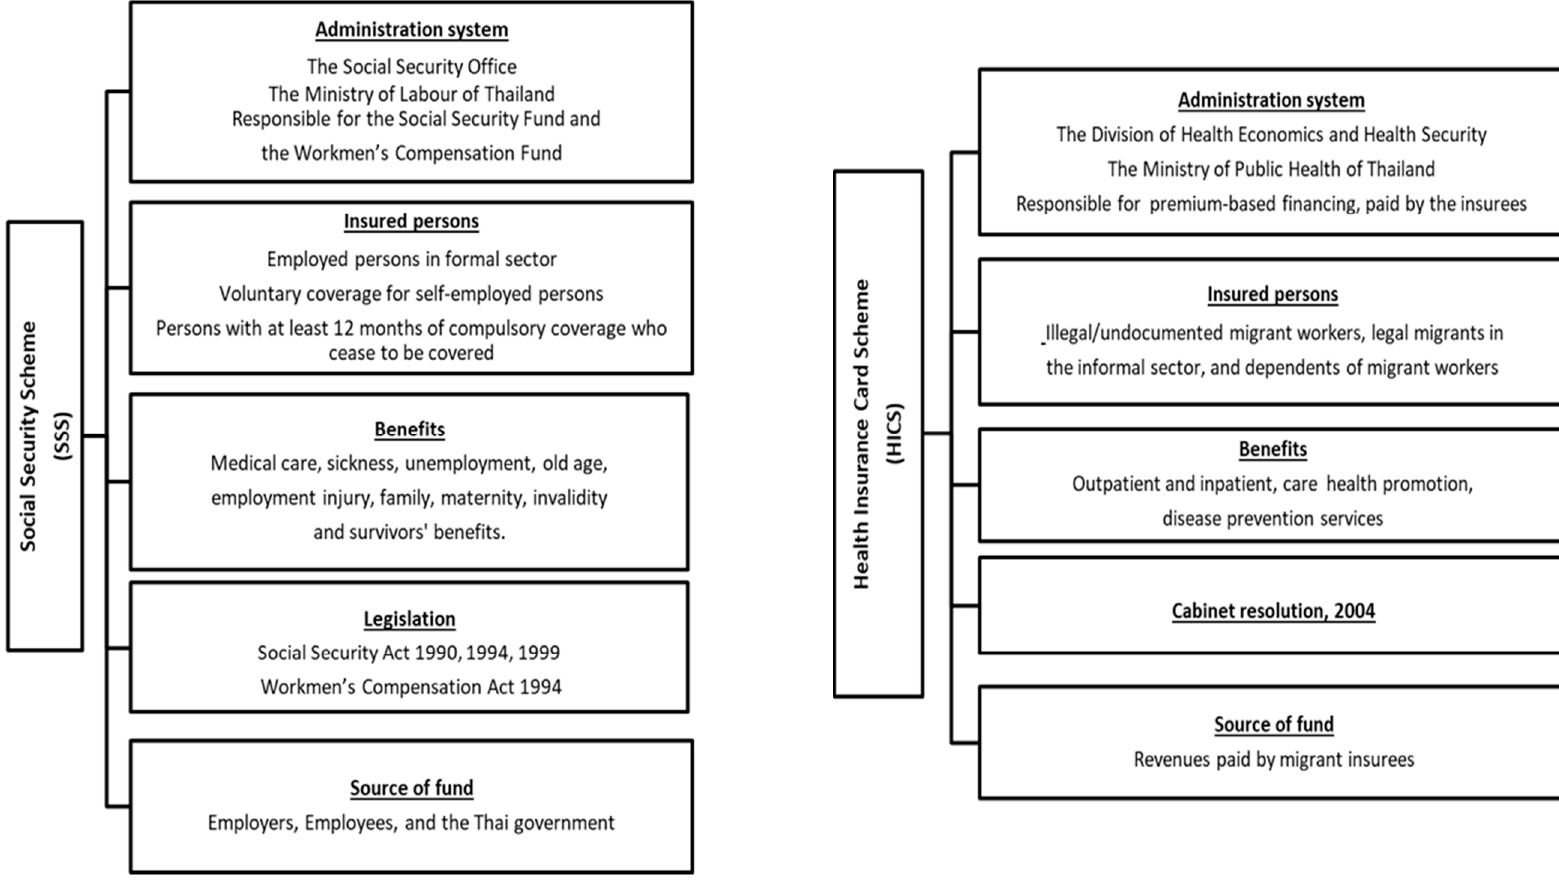
Figure 1. Characteristics of the SSS and HICS.